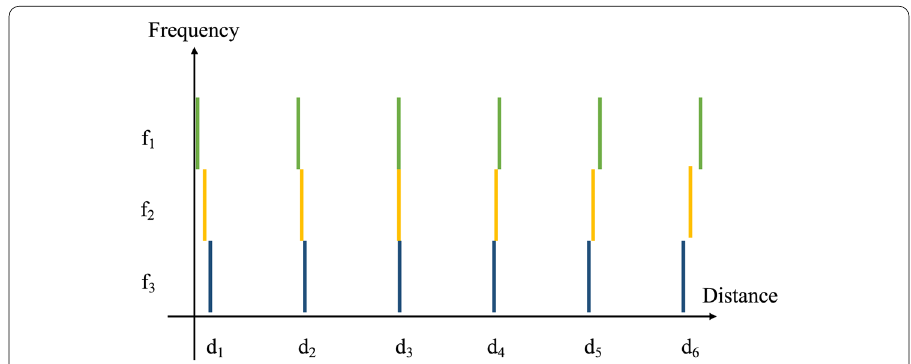
Fig. 4 Schematic diagram of